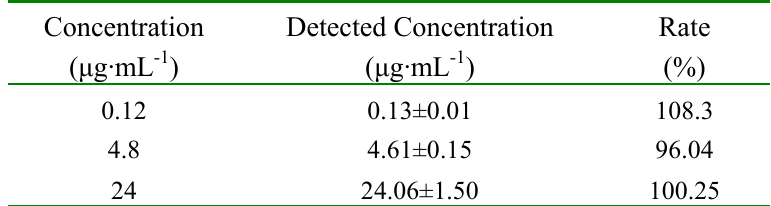
Table 7. Extraction Rate of Caffeine (mean ±SD, n=3).